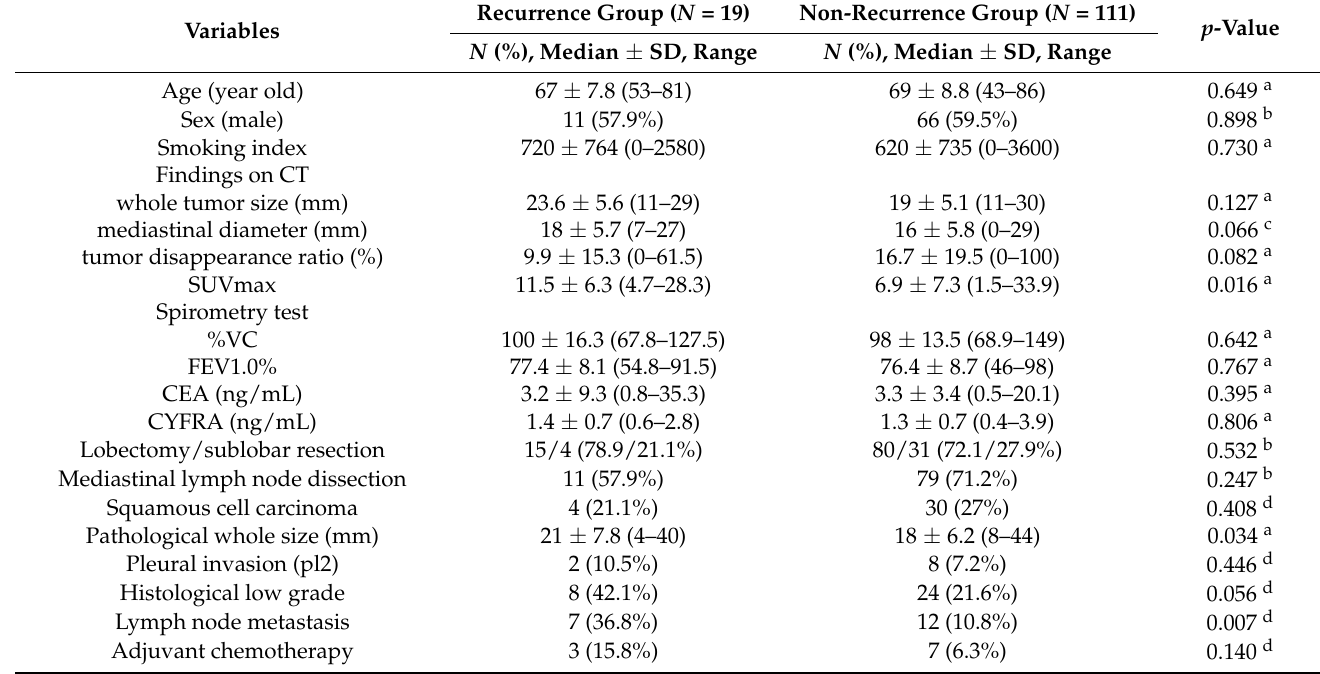
ing five patients. Intrathoracic recurrence included intrathoracic lymph node metastasis (nine patients), status post wedge resection (two patients) or lobectomy (seven patients), intrapulmonary metastasis (three patients), and intrathoracic dissemination (two patients). Table 2. Comparison with recurrence group and non-recurrence